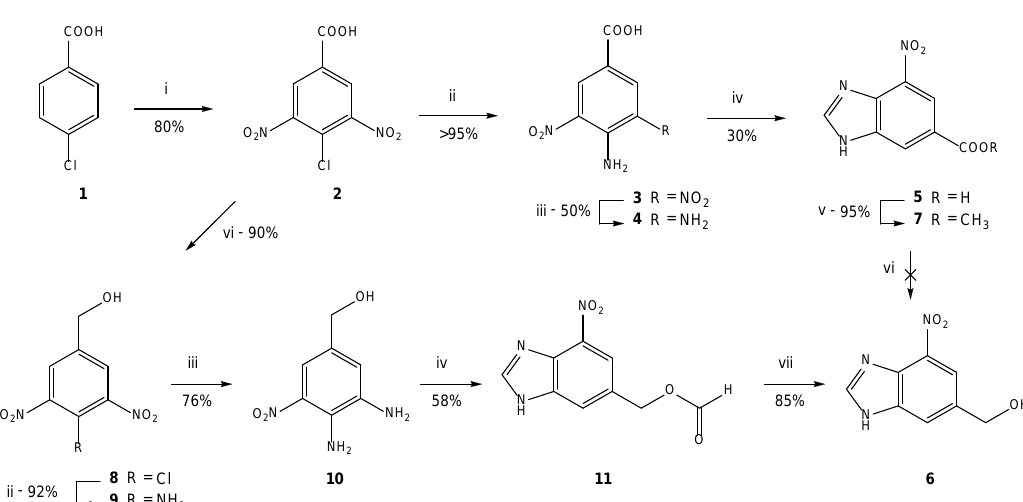
Scheme 1. Synthesis of 6-hydroxymethyl-4-nitro-benzimidazole. Reagents and conditions: (i) conc. H 2 SO 4 , KNO 3 , 130 ◦ C; (ii) methanol, aqueous ammonia, 65 ◦ C; (iii) methanol / water (3:1), sodium sulfide,